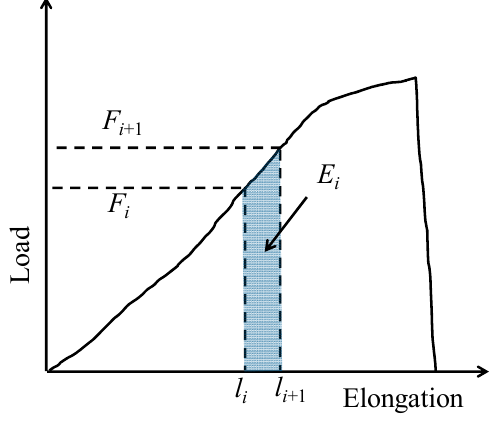
Figure 5. The concept of energy absorption.